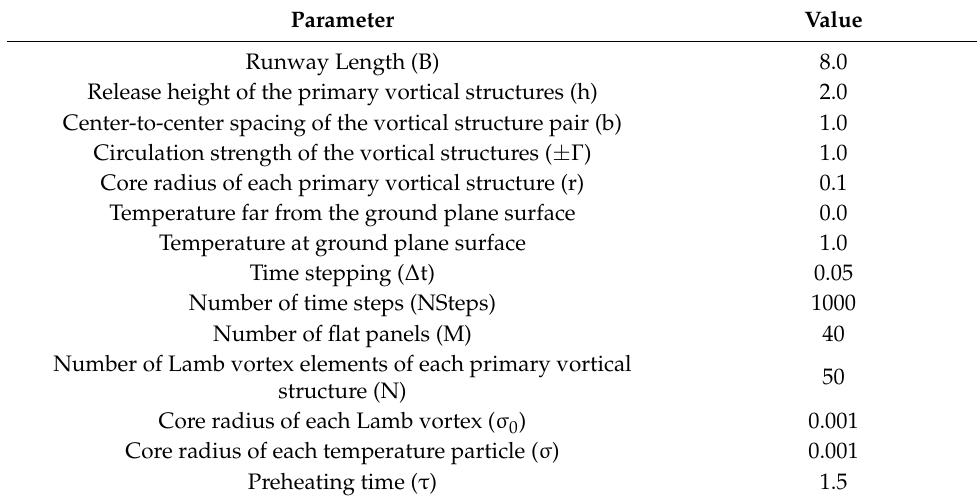
Table 1. Estimated dimensionless values of numerical simulation parameters. Parameter Value Runway Length (B) 8.0 Release height of the primary vortical structures (h) 2.0 Center-to-center spacing of the vortical structure pair (b) 1.0 Circulation strength of the vortical structures ( ± Γ ) 1.0 Core radius of each primary vortical structure (r) 0.1 Temperature far from the ground plane surface 0.0 Temperature at ground plane surface 1.0 Time stepping ( ∆ t) 0.05 Number of time steps (NSteps) 1000 Number of flat panels (M) 40 Number of Lamb vortex elements of each primary vortical 50 structure (N) Core radius of each Lamb vortex ( σ 0 ) 0.001 Core radius of each temperature particle ( σ ) 0.001 Preheating time ( τ )